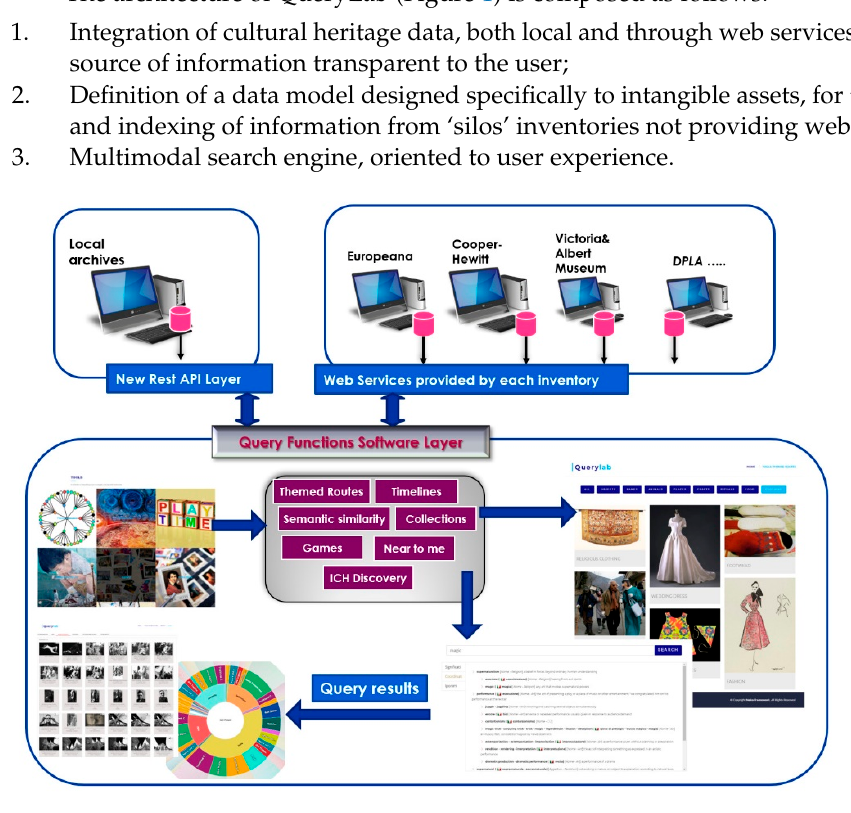
Figure 1. Overview of the QueryLab schema.